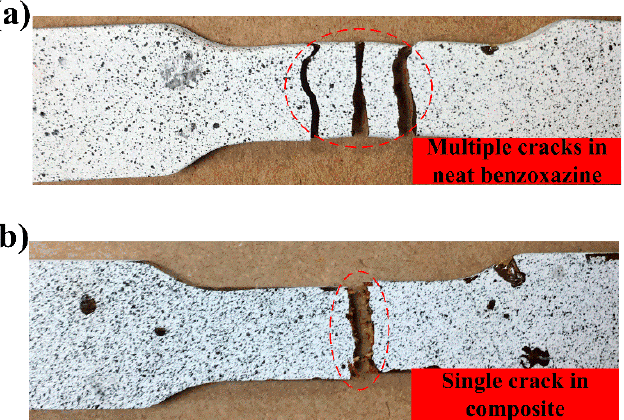
Figure 13. Bamboo fibers could effectively hinder the rapid propagation of cracks in composites. ( a ) Neat benzoxazine matrix, ( b ) ABP.